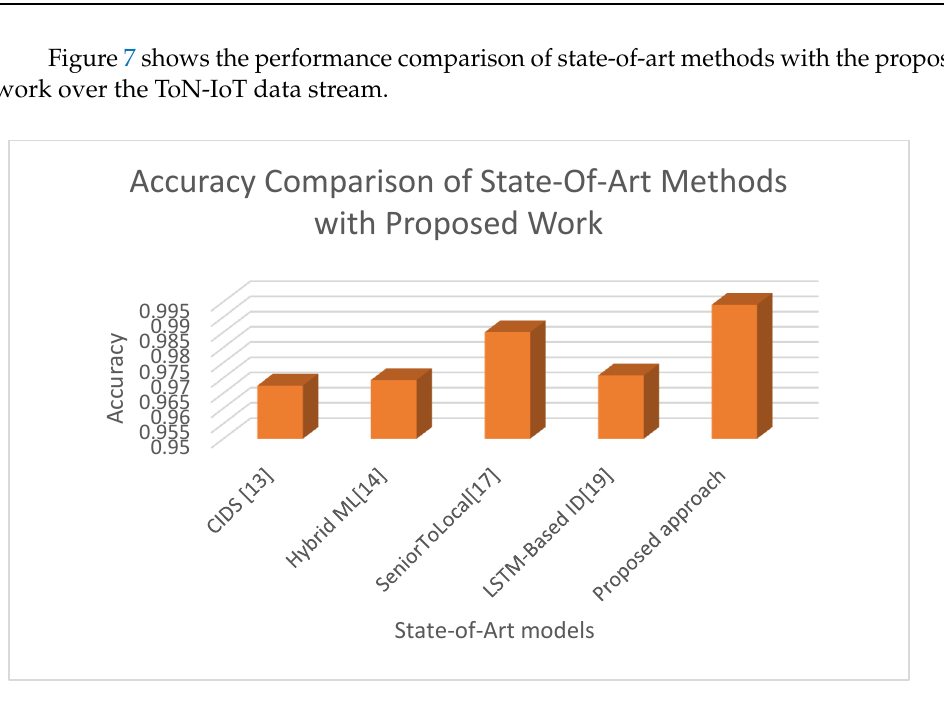
Figure 7. Comparison of accuracy.